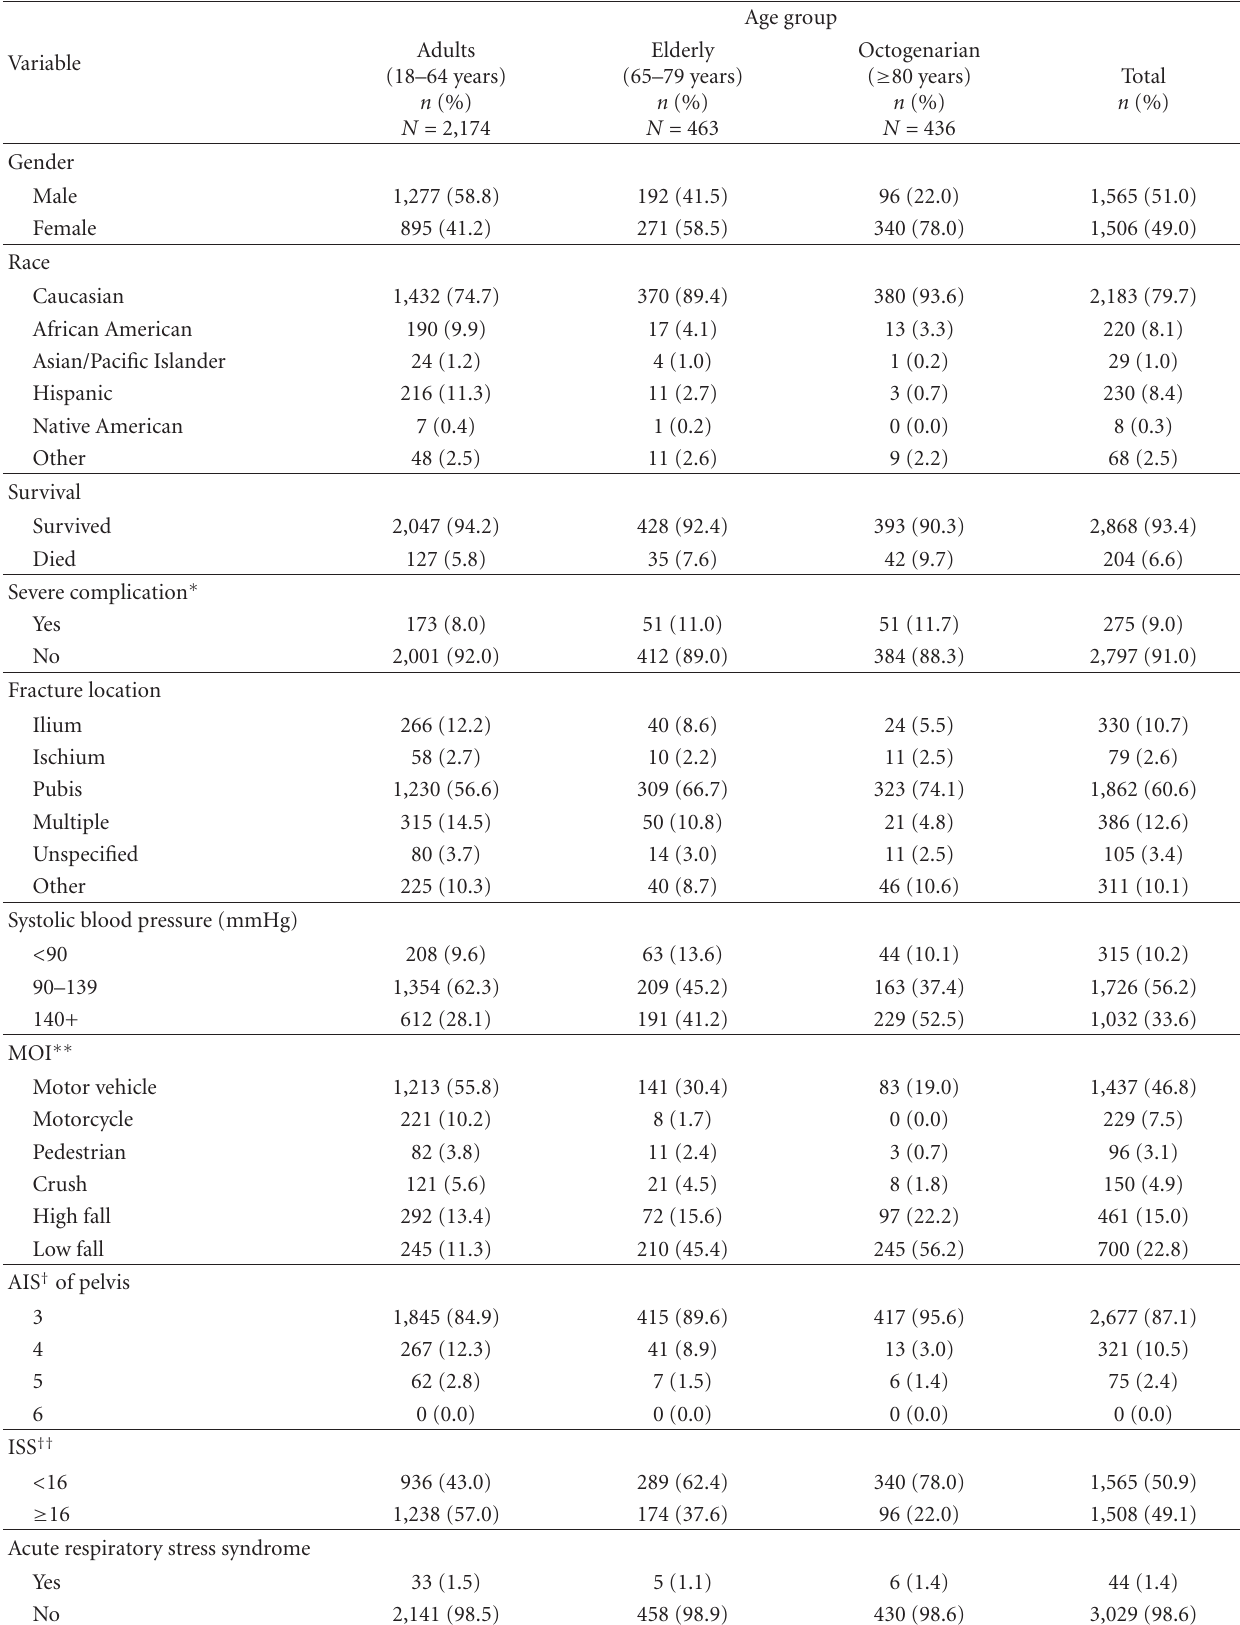
Table 3: Frequency distribution of characteristics for the population with isolated, closed, and severe pelvic fractures (AIS ≥ 3), n =